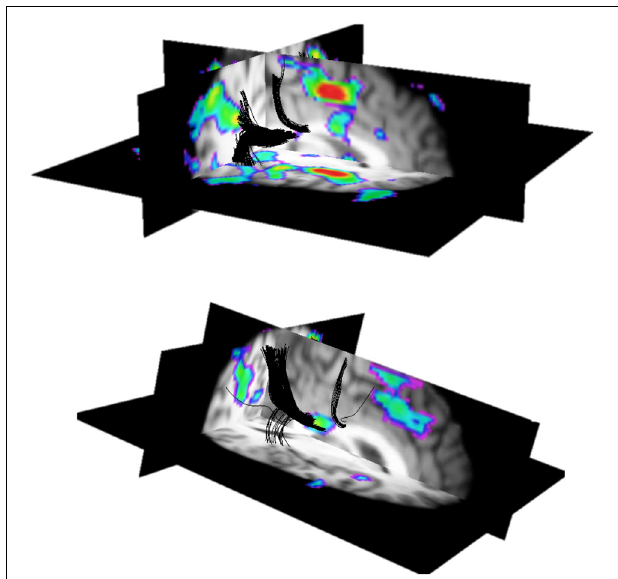
FIGURE 3 | 3D views of white matter fMRI activation co-localized to functionally-guided tractography in two subjects. An interhemispheric transfer task was used to elicit gray and white matter activation (rainbow color scale). Tracts (black) were seeded from regions of gray matter activation to determine whether the white matter activation was structurally connected to activation in gray matter. This work provided evidence for the anatomic basis of white matter activation; that is, regions of white matter activation are structurally connected to the activated network in gray matter. A discussion of individual variability in the location of callosal activation can be found in (Mazerolle et al., 2010). Figures were generated from data selected from (Mazerolle et al.,